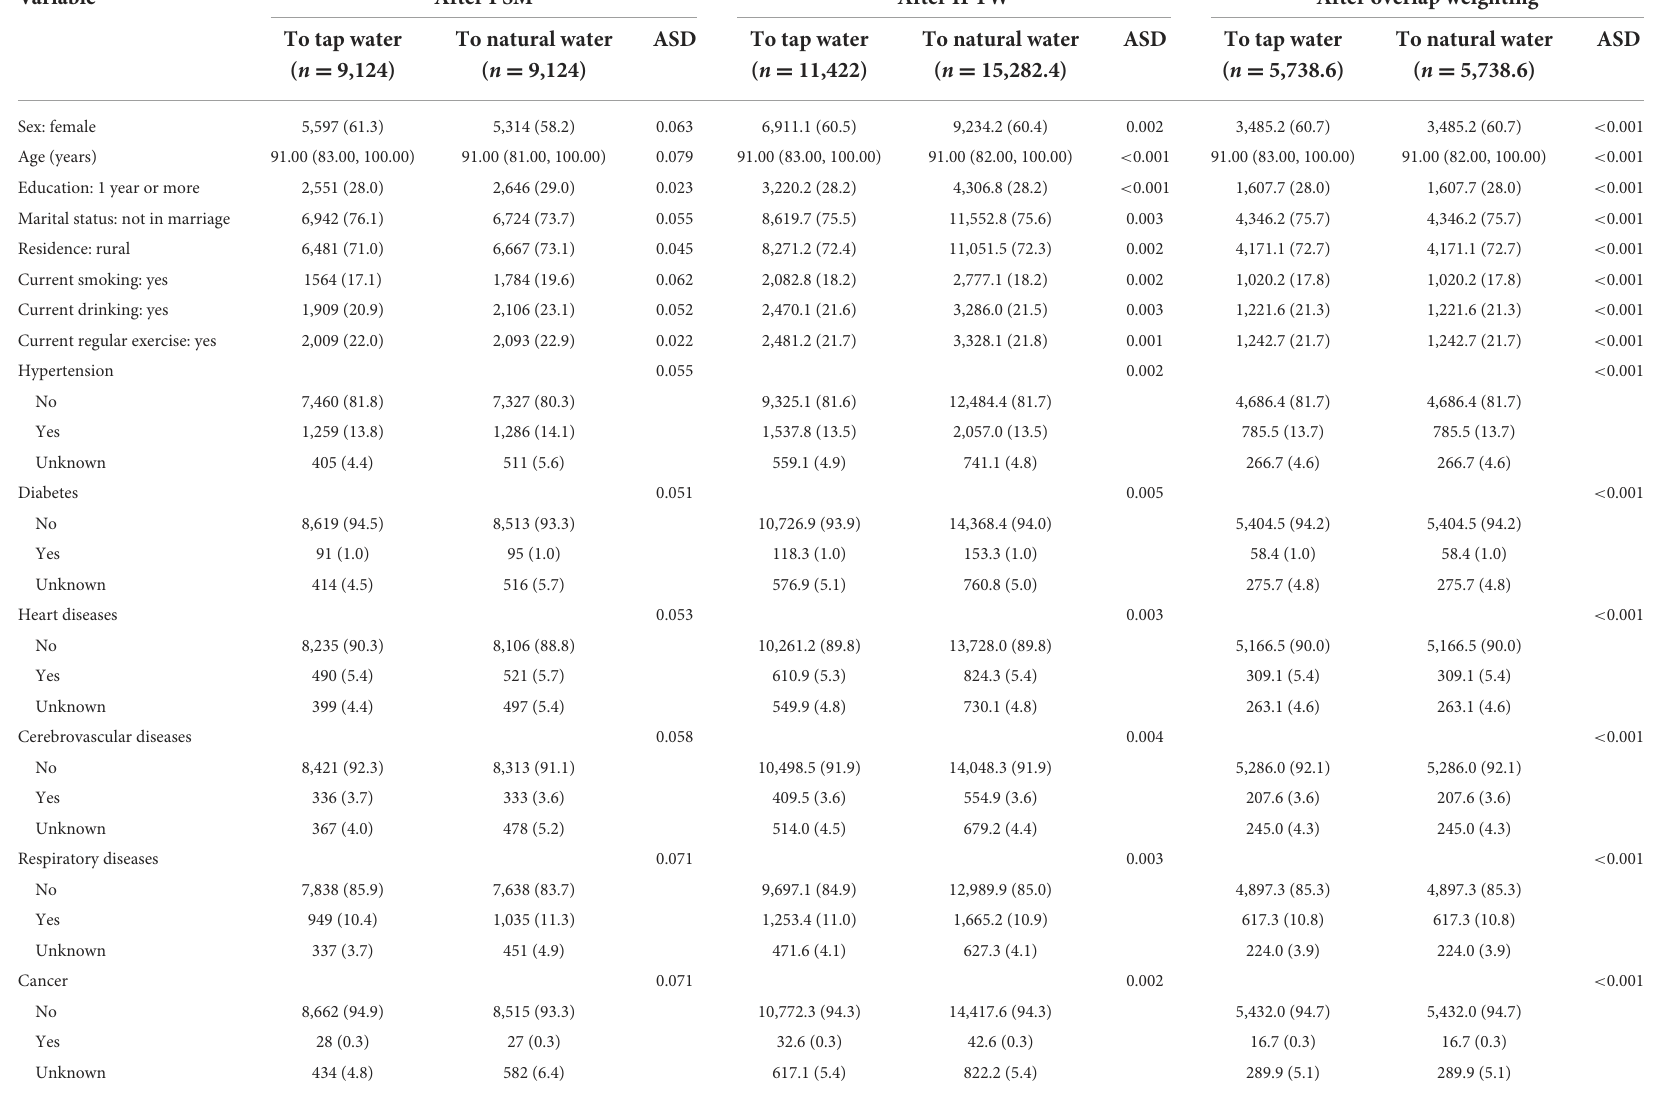
TABLE 2 Baseline characteristics stratified by baseline drinking water sources after PSM, IPTW, and overlap weighing.